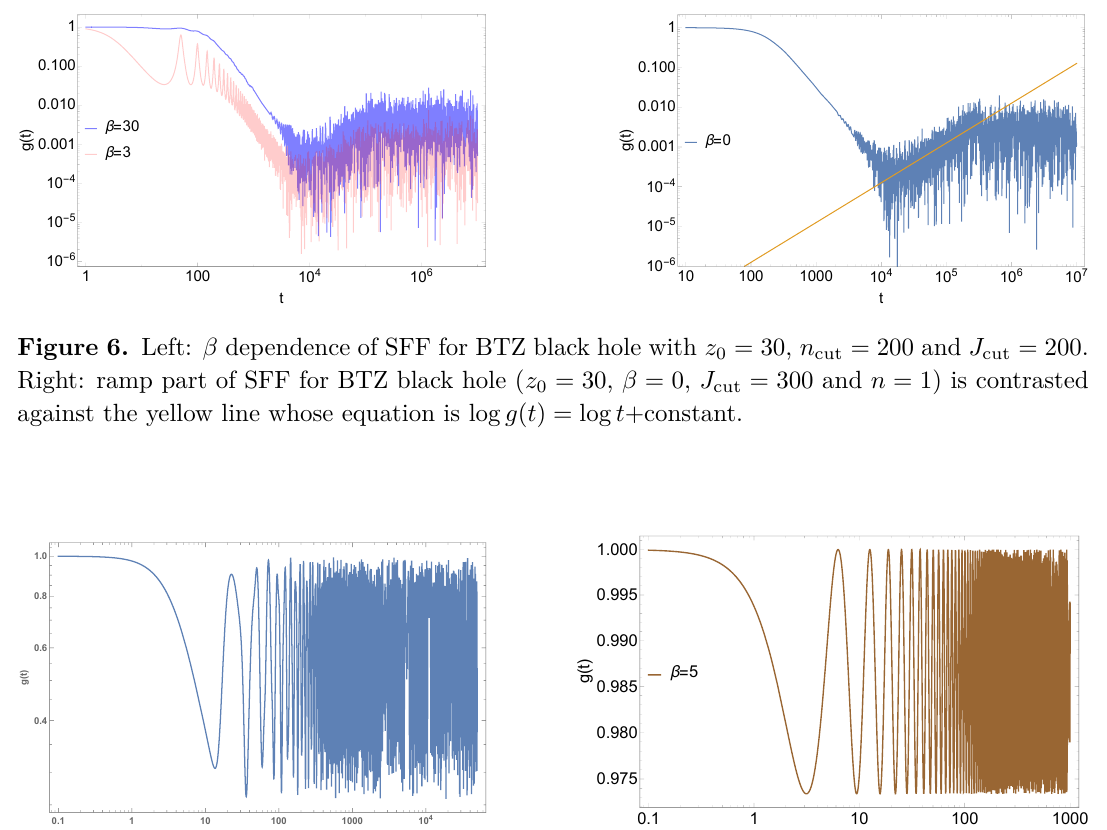
= (∆ + l + 2 n ) , where ∆ = 2 , l = 100 , n = 1 and nl cut